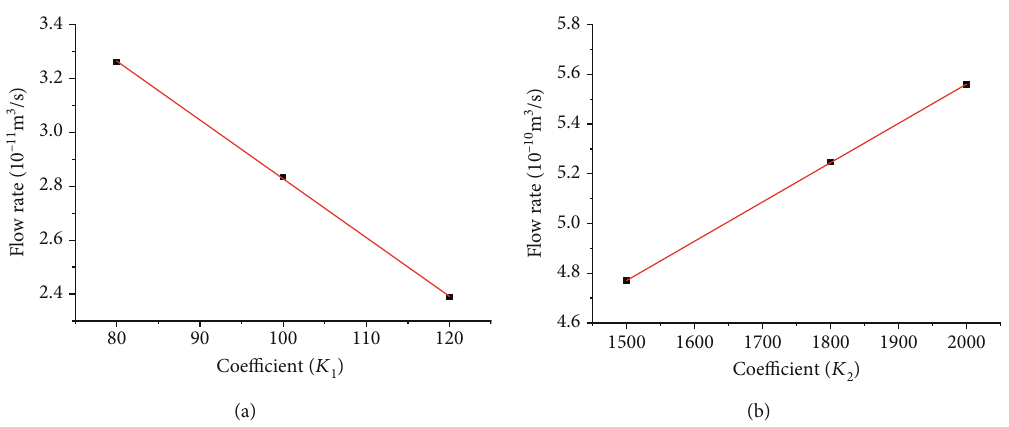
Figure 9: Flow rates and corresponding coe ffi cients: (a) K